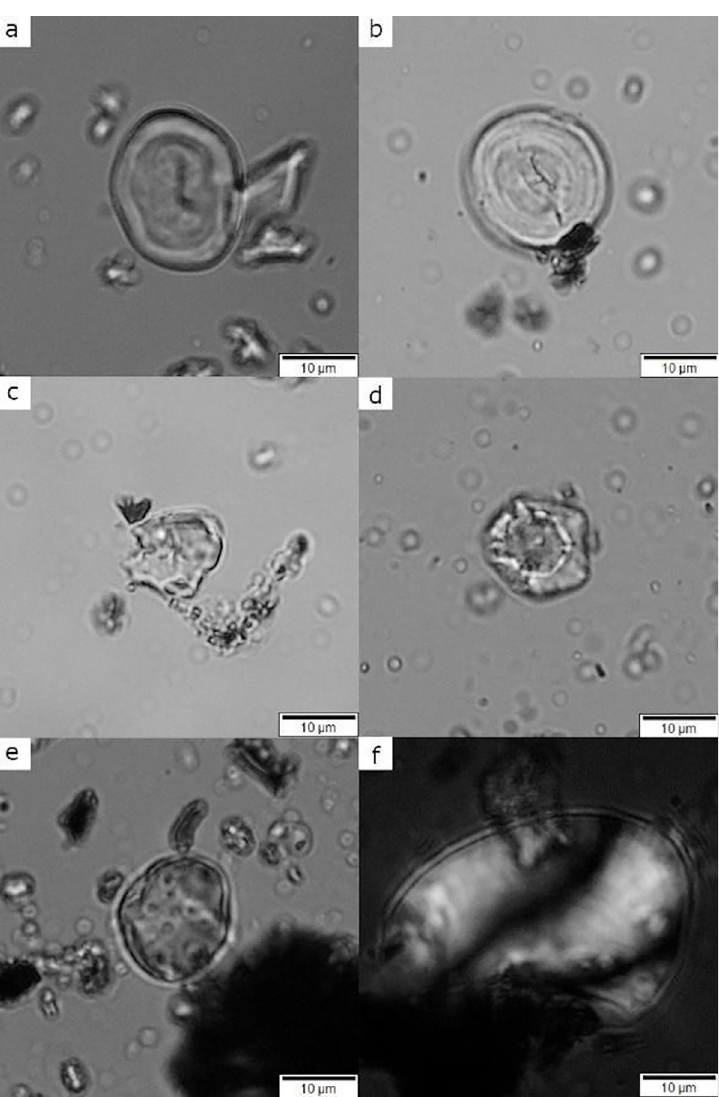
Fig 6. Archaeological starch grains recovered from grinding stones with evident structural damage caused by anthropic, biological and taphonomic processes, observed under 400x magnification. a–b) Type 1 starch grains with signs of initial stages of gelatinization; c) Type 2 starch grain presenting signs of initial stages of gelatinization; d) Type 2 starch grain with a central depression, pitting and channeling probably caused by enzymatic damage; e) Unidentified starch grain exhibiting pitted surface commonly caused by enzymes and microbial activity; f) Broken USO starch grain, probably caused by mechanical action (grinding, pounding, or mashing). Damage identifications based on Henry et al. [119]; Wang et al. [172]; Paga´n-Jime´nez [166, 171].